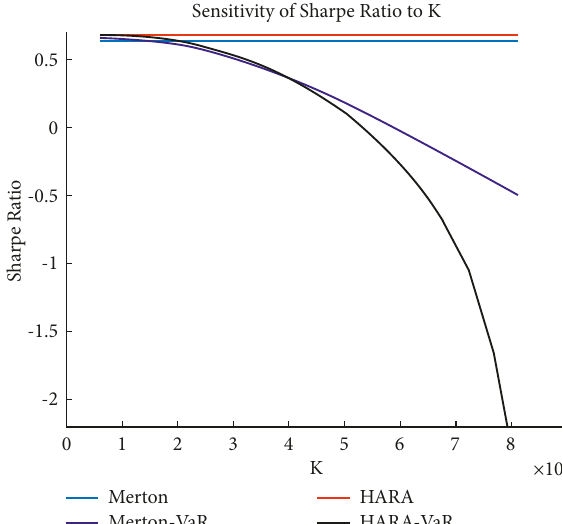
Figure 4: Sharpe ratio sensitivity to K for Merton (Power), Merton-VaR (Power-VaR), HARA, and